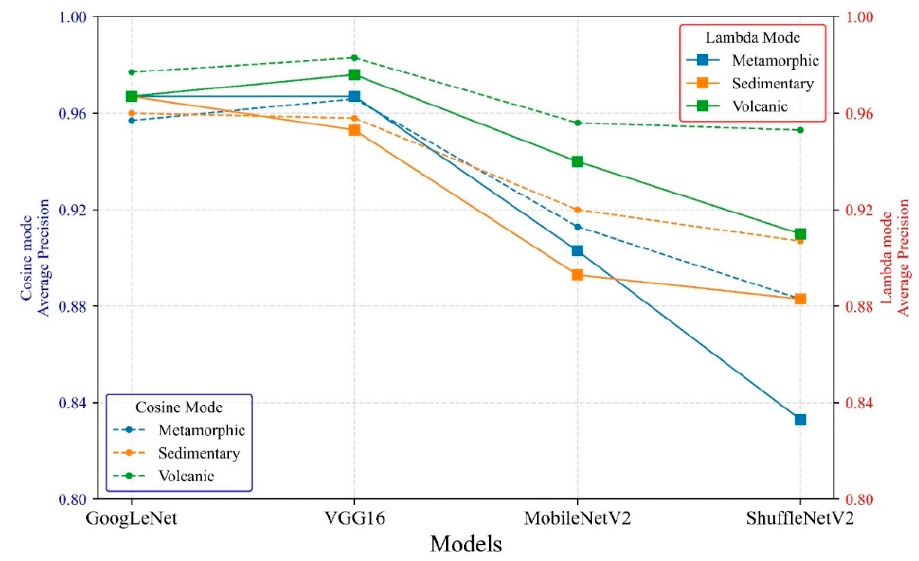
Figure 25. Model average precision under two learning-rate decay modes. The left dotted line indicates cosine learning-rate decay result, and the right solid line is the result of lambda.